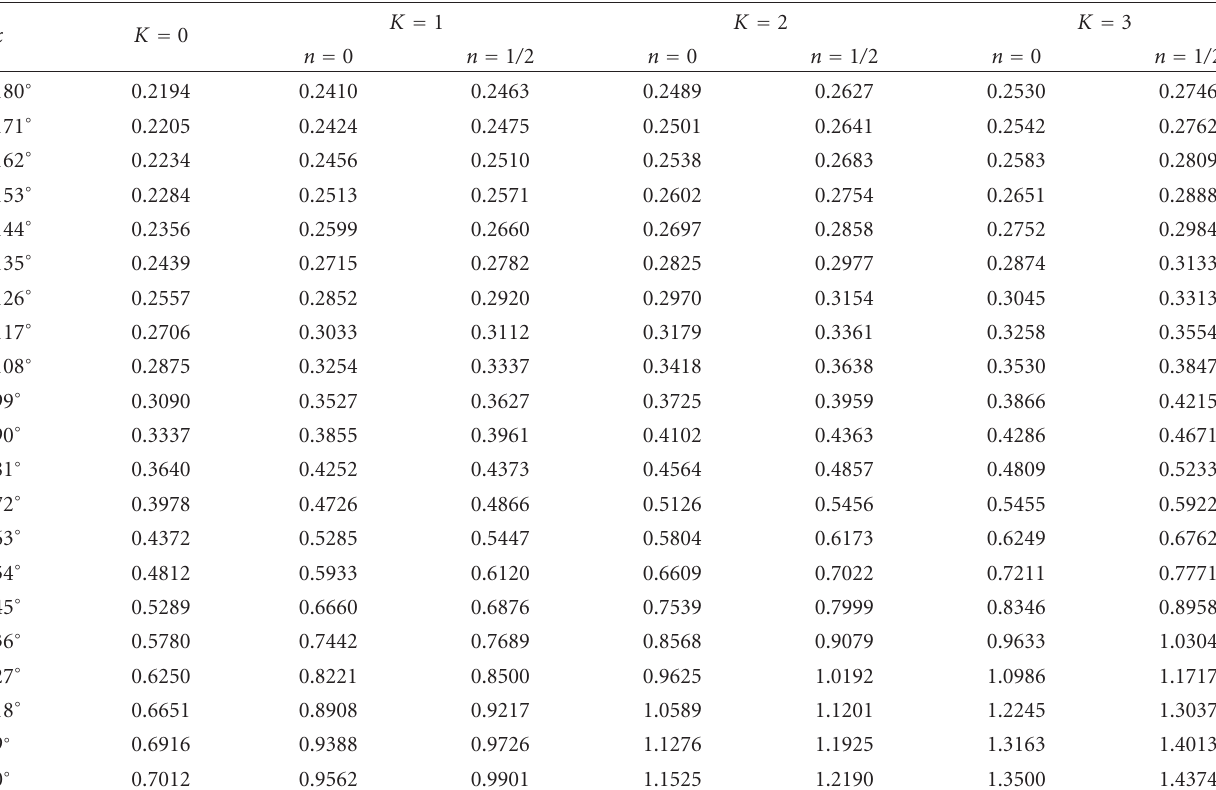
Table 1: The separation times along the cylinder surface when Pr = 1 and α = − 3 (opposing